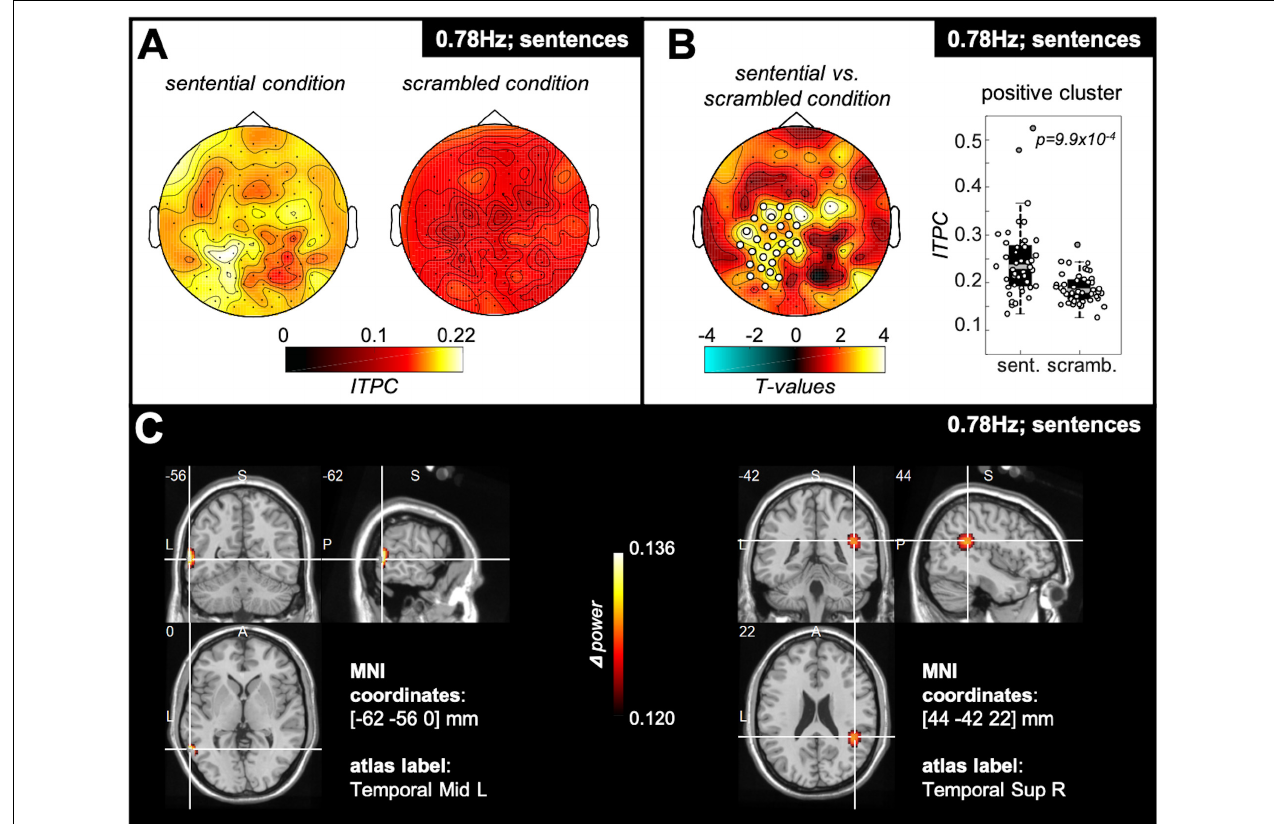
FIGURE 3 | Spatial cluster specific for hearing sentences. (A) Topography plots show colour-coded ITPC values at the sentence frequency (i.e., 0.78 Hz) for the sentential and the scrambled condition. The data were pooled over all participants of the passive and the word group. (B) When computing the difference between sentential and scrambled condition, a significant positive electrode cluster ( p = 9.9 × 10 - 4 ) was found, located left-lateralised over parieto-temporal recording sites. The box plot to the right reflects ITPC values over the electrodes of the positive cluster, showing stronger ITPC at the sentence frequency for the sentential (“sent.”) compared with the scrambled (“scramb.”) condition. The central gray line marks the median, and the bottom and top edges the 25th and 75th percentiles of the data, respectively. Error bars extend to the extreme values, excluding outliers, and circles represent data of individual participants. Filled gray circles represent outliers. (C) Results of the DICS source estimation of the contrast sentential vs. scrambled condition. The source estimation shows colour-coded the difference in power at the sentence frequency between the sentential and the scrambled condition for all subjects of the passive and the word group in functional ortho-plots (functional values are thresholded to present only the top 10% virtual electrodes). The peak areas of the source estimation were identified as left middle temporal gyrus as well as the right superior temporal gyrus. (Letters indicate anatomical landmarks; A = anterior, P = posterior, L = left, S = superior; numbers indicate location of crosshair in the brain in